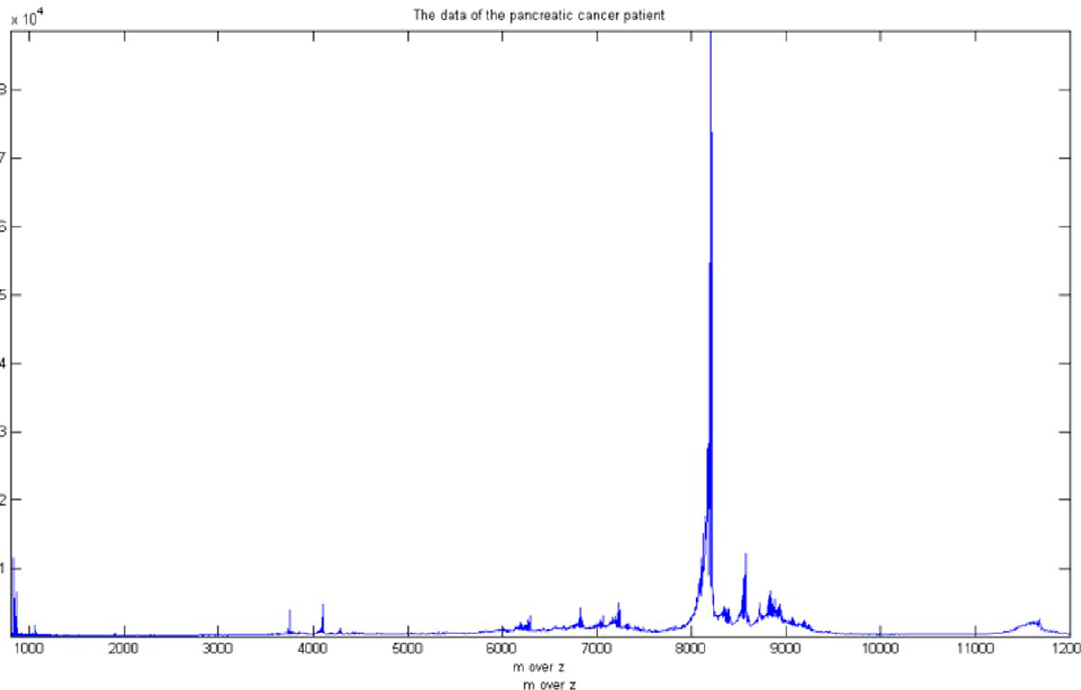
Figure 3. Sample pancreatic cancer data. Original data of pancreatic cancer provided by Ge and Wong (2008). In this dataset, there is more noise where the peaks exist.